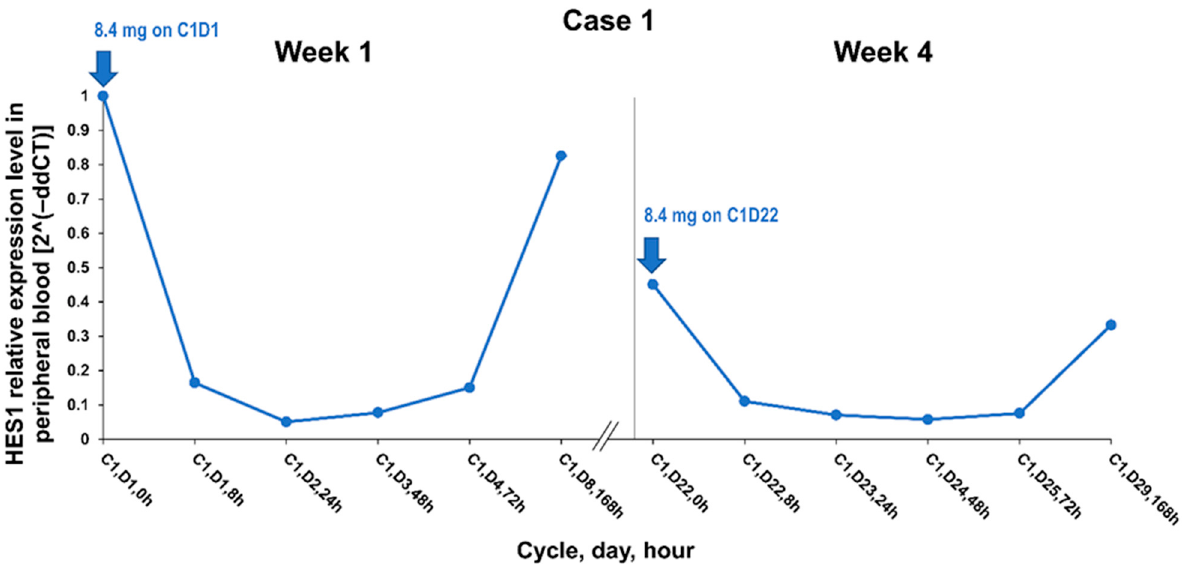
Figure 3. HES1 relative expression level at week 1 and week 4 of cycle 1 in Case 1. Abbreviations: C, cycle; D, day; h, hour.